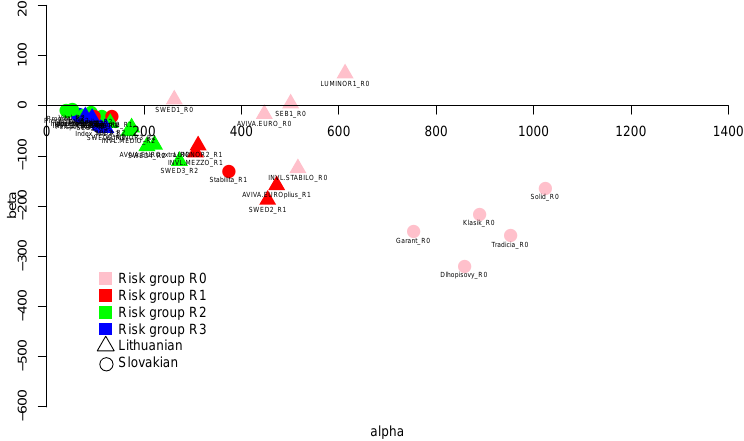
Figure 6. Scatter plot of estimates of shape and asymmetry parameters of NIG distribution for Slovak and Lithuanian pension